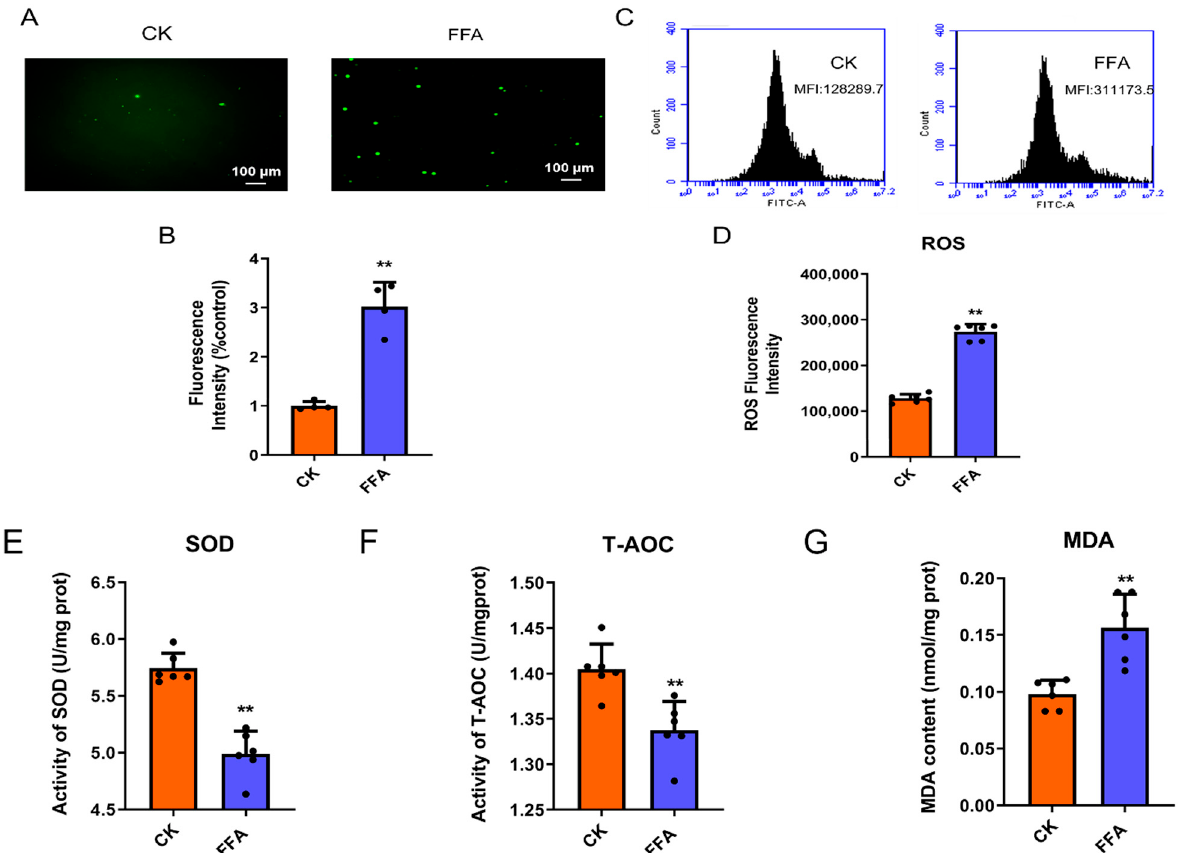
Figure 2. Effect of FFA treatment for 24 h on oxidative stress in primary hepatocytes of laying hens. ( A – D ) Effect of FFA on intracellular ROS levels ( A ): inverted fluorescence microscopy; ( B ): Average fluorescence intensity of ROS; ( C , D ): flow cytometry. ( E ) Cellular superoxide dismutase activity in each experimental group. ( F ) Cellular malondialdehyde content in each experimental group. ( G ) Total antioxidant capacity of cells in each experimental group. Data are shown as the mean ± SD (n = 6), with (**) p < 0.01.